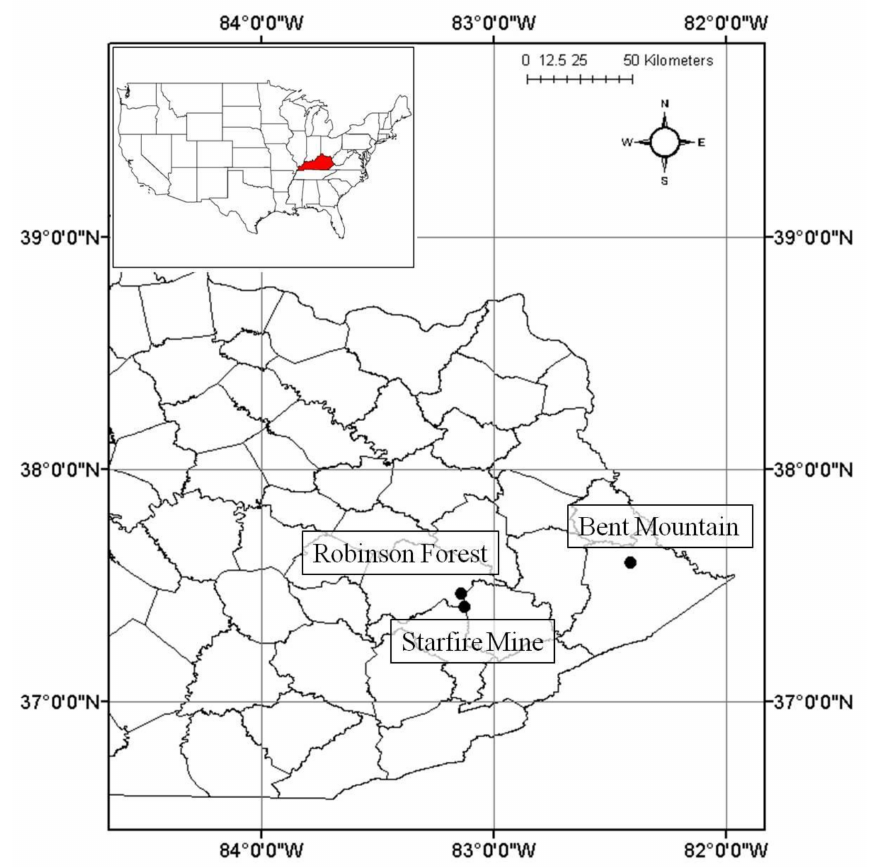
Figure 1. Location of reclaimed mine sites and unmined forest control, Breathitt (Robinson Forest), Perry (Starfire Mine), and Pike (Bent Mountain) Counties, Eastern Kentucky,